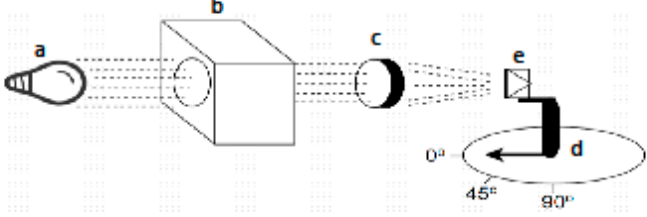
Figure 8. Schema of the instrumentation in the black-room laboratory. ( a ) Horizontal quartz-halogen standard lamp; ( b ) Zeiss spectral monochromatic; ( c ) spherical lenses; ( d ) mechanical platform with focus variable angle; ( e ) the sensor (installed on a rotating platform).